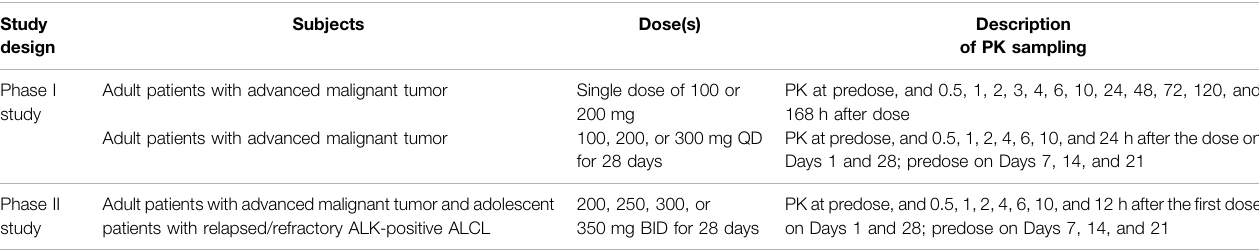
TABLE 1 | Summary of the studies included in the